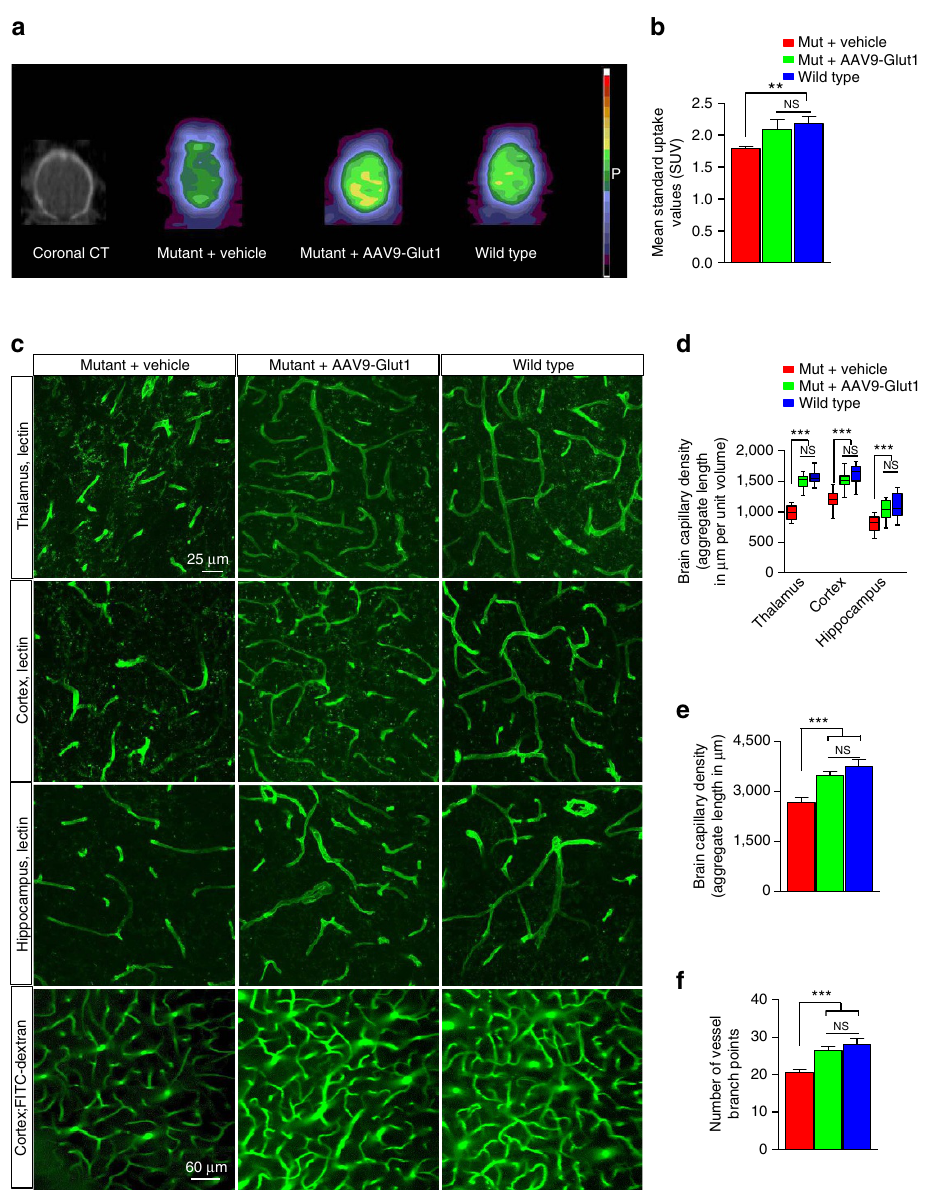
Figure 5 | Normal cerebral microvasculature and brain glucose uptake in mutants treated early with AAV9-Glut1. ( a ) Representative coronal images of small PET scans at 3–6min following administration of 18 F-FDG, show reduced uptake in the brain of a mutant mouse relative to WT and mutant mice treated with AAV9-Glut1. ( b ) Mean brain standardized uptake values (SUVs) at 3–6min after injection of 18 F-FDG in WTcontrols (SUV ¼ 2.2 ± 0.11) and mutants treated with either vehicle (SUV ¼ 1.8 ± 0.04) or AAV9-Glut1 (SUV ¼ 2.1 ± 0.15). **, P o 0.01, one-way ANOVA, N Z 4 mice in each cohort. ( c ) Immunohistochemistry or live-imaging experimental results of the brain microvasculature of model mice administered AAV9-Glut1 depicts a capillary network that is as elaborate and dense as that of WT, control littermates. Note reduced density and fragmented aspect of the brain capillaries in all three brain regions of vehicle-treated mutants. Also note (lower panels) the fewer FITC-Dextran perfused vessels in vehicle-treated but not AAV9-Glut1-treated model mice. Graphical representations of cerebral capillary densities of the three groups of mice following an analysis of ( d ) 4% PFA fixed tissue or ( e , f ) 2-photon live-imaging experiments. ***, P o 0.001, one-way ANOVA, n Z 9 regions from each of N Z 3 mice of each